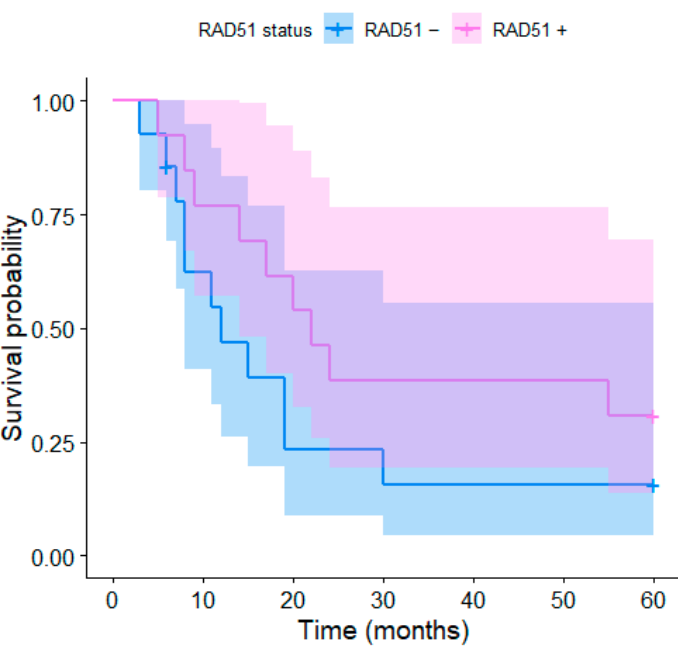
Figure 4. Kaplan–Meier curves of the 2-year survival for RD51+ and RAD51 − patients.